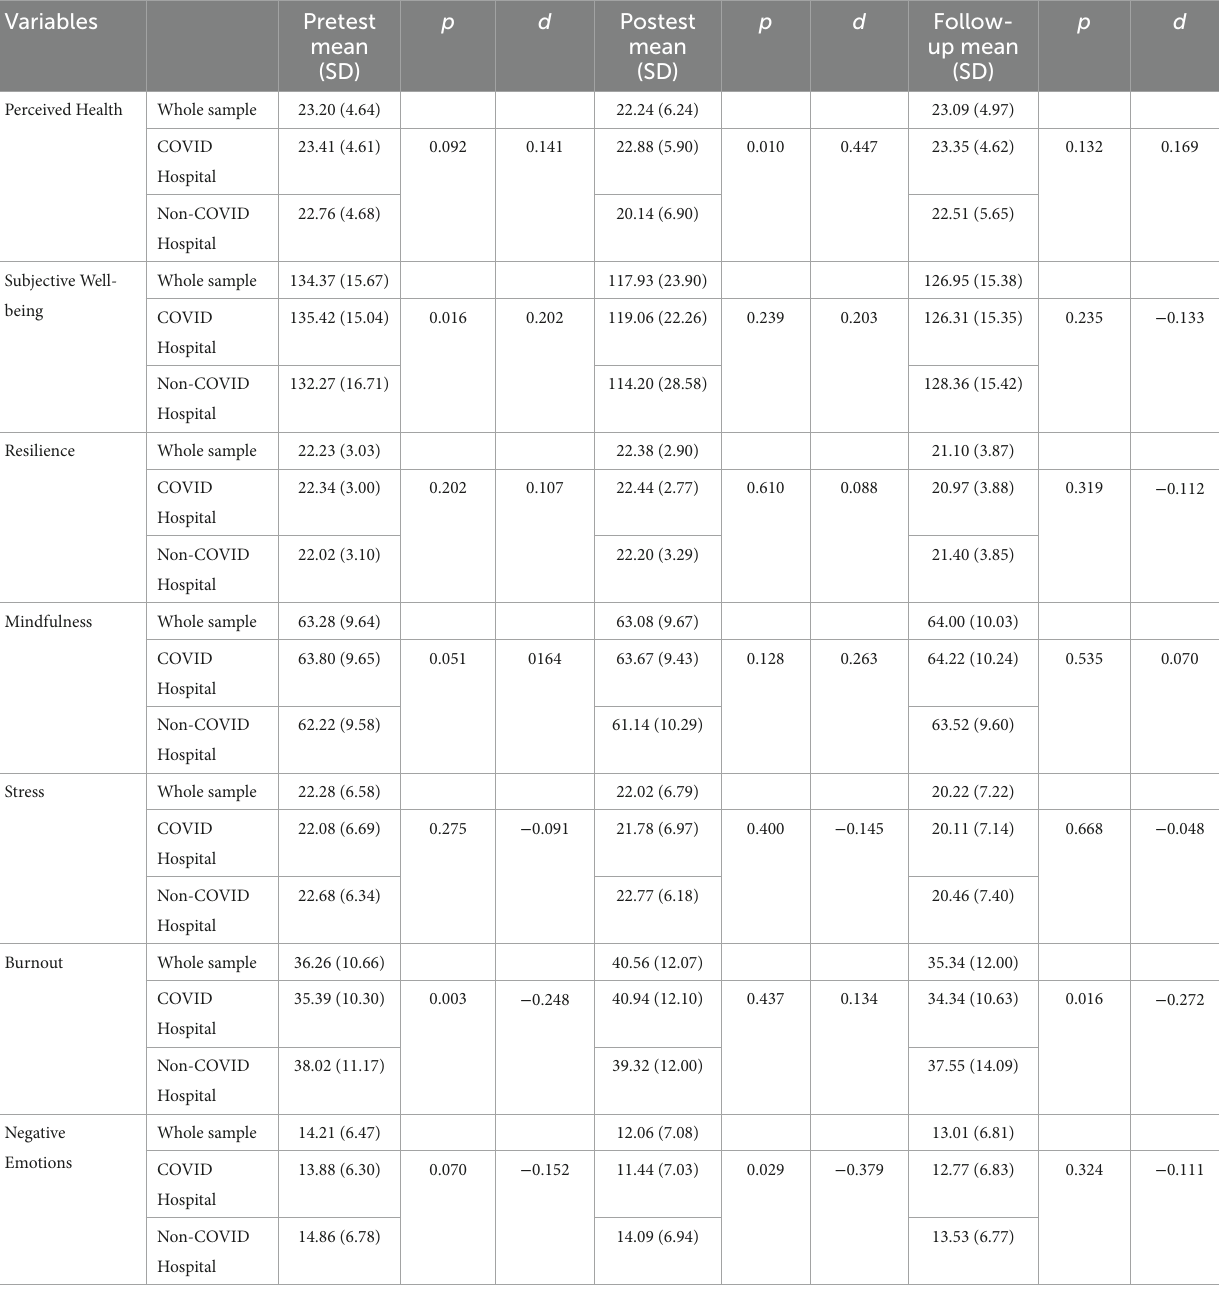
TABLE 2 Mean scores of perceived health, subjective well-being, resilience, mindfulness, stress, burnout, and negative emotions for the whole sample and divided by COVID Hospital and Non-COVID Hospital nurses at pretest, postest, and 6-month follow-up.